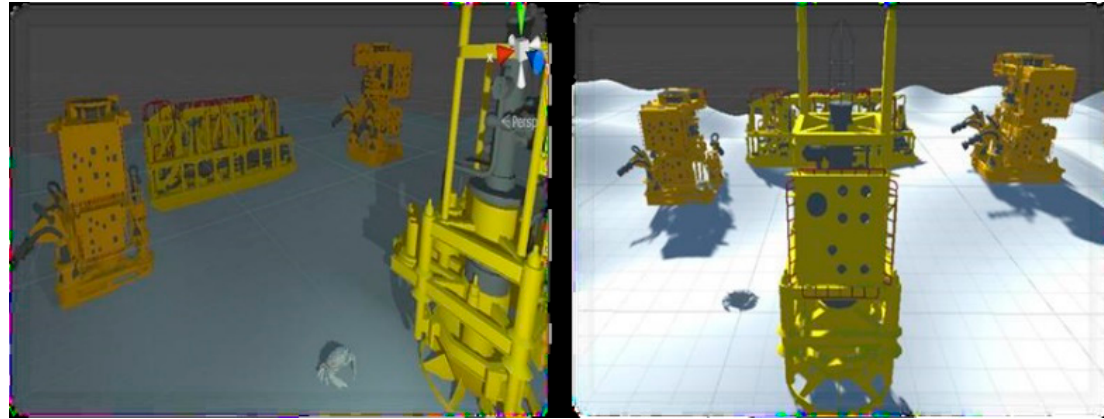
Figure 12. Offshore oil field virtual scene [29]. Figure 12. O ff shore oil field virtual scene